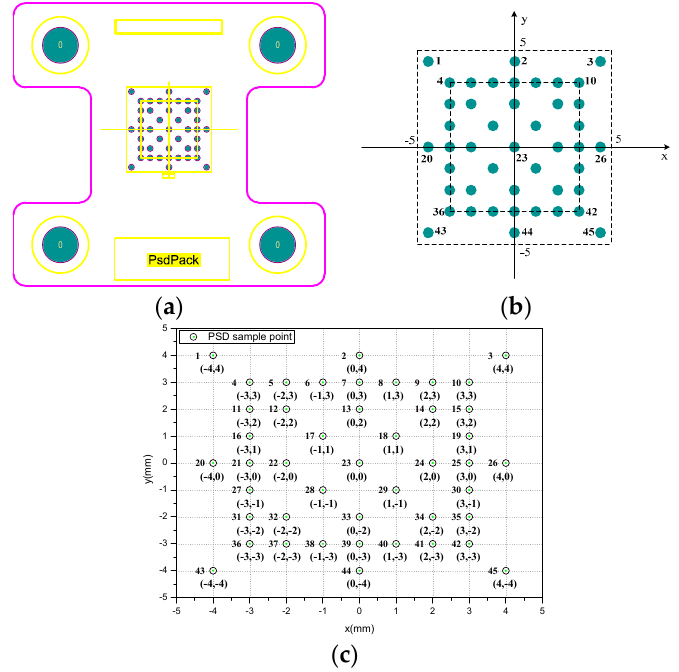
Figure 2. ( a ) The template with 45 0.5 mm diameter holes. ( b ) Template hole position coordinates. ( c ) Fixed coordinate points selected on the PSD (Number 1 through 45 from left to right and top to bottom).